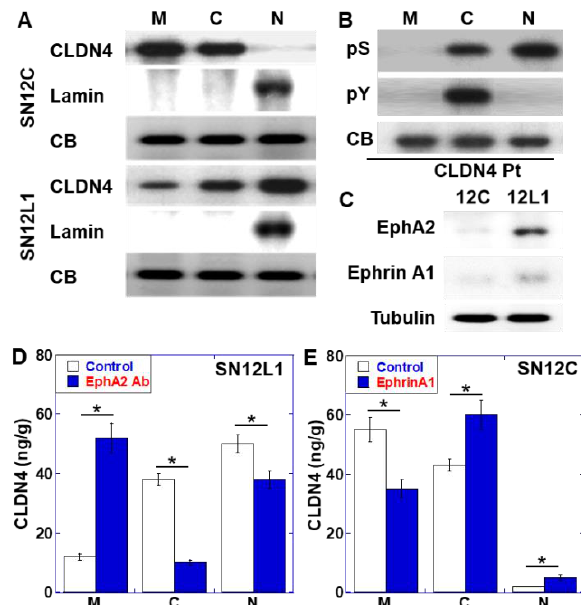
Figure 2. E ff ect of EphA2 / Ephrin A1 on the subcellular localization of CLDN4 in renal cell Figure 2. Effect of EphA2/Ephrin A1 on the subcellular localization of CLDN4 in renal cell carcinoma cell line. ( A ) Subcellular localization of CLDN4 in SN12C (low metastatic parental cell line) and